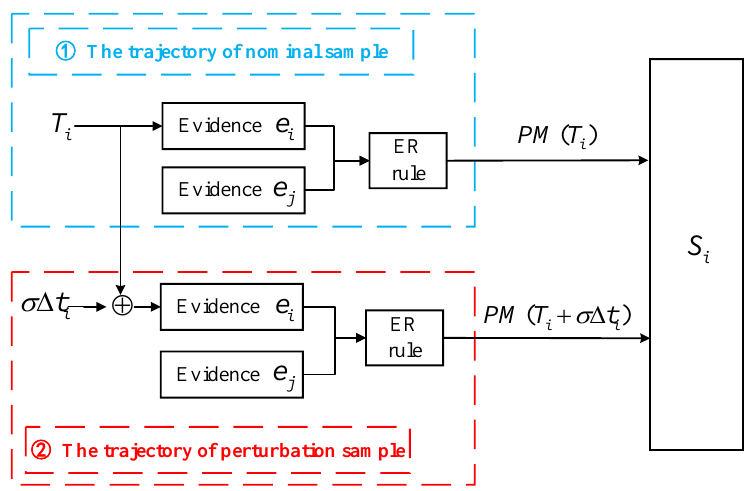
Figure 2. Fusion process under perturbation by the ER rule.